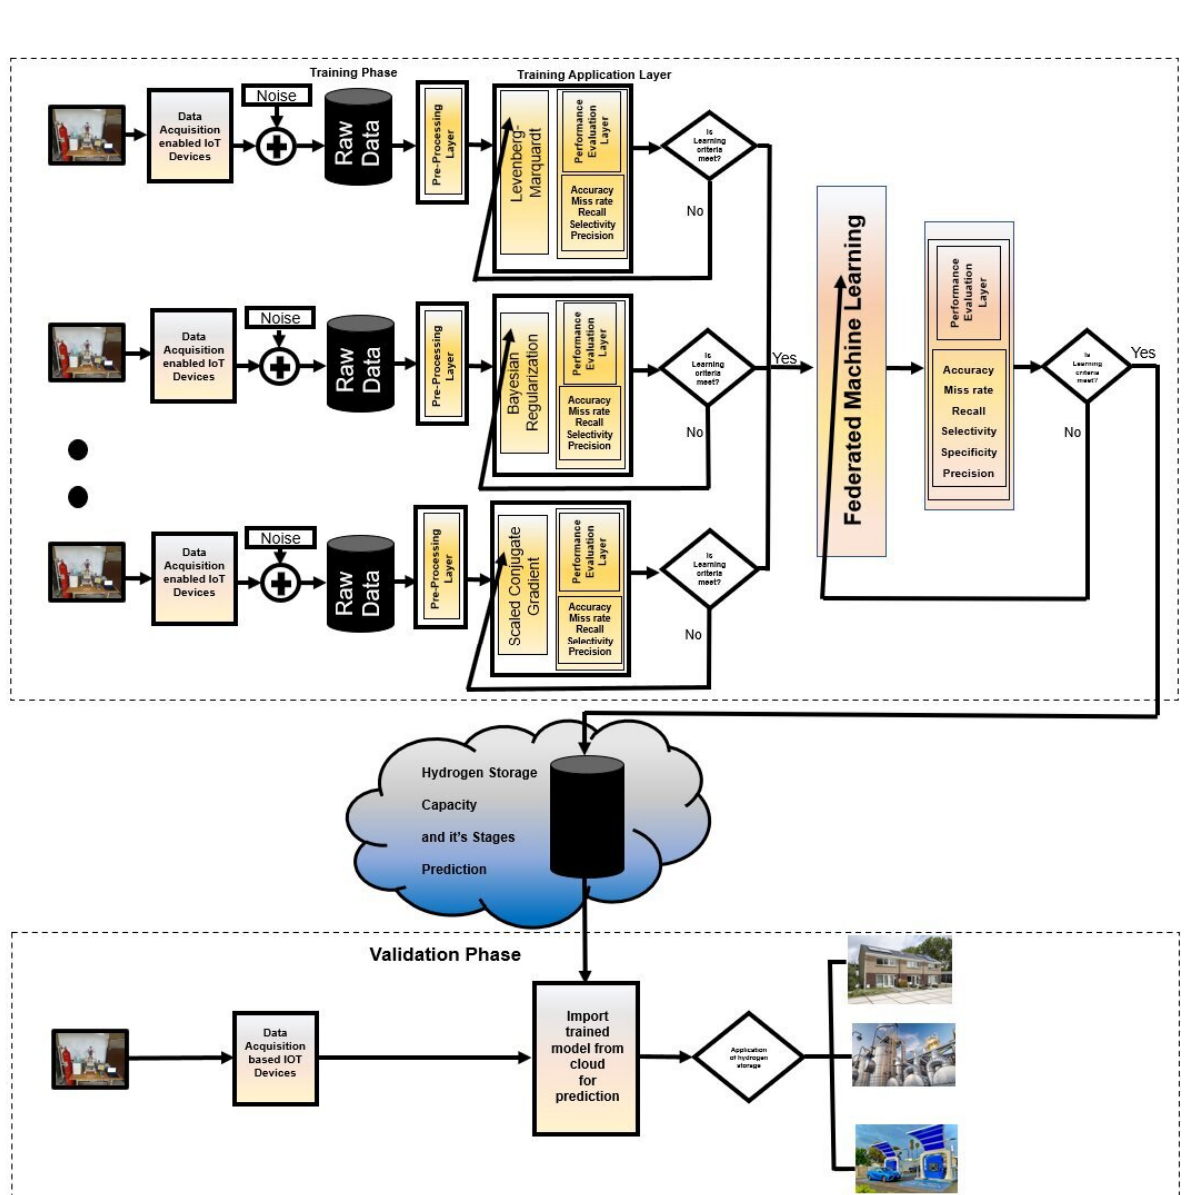
Figure 2. Hydrogen Storage Prediction System empowered with Weighted Federated Machine Learning (HSPS-WFML).